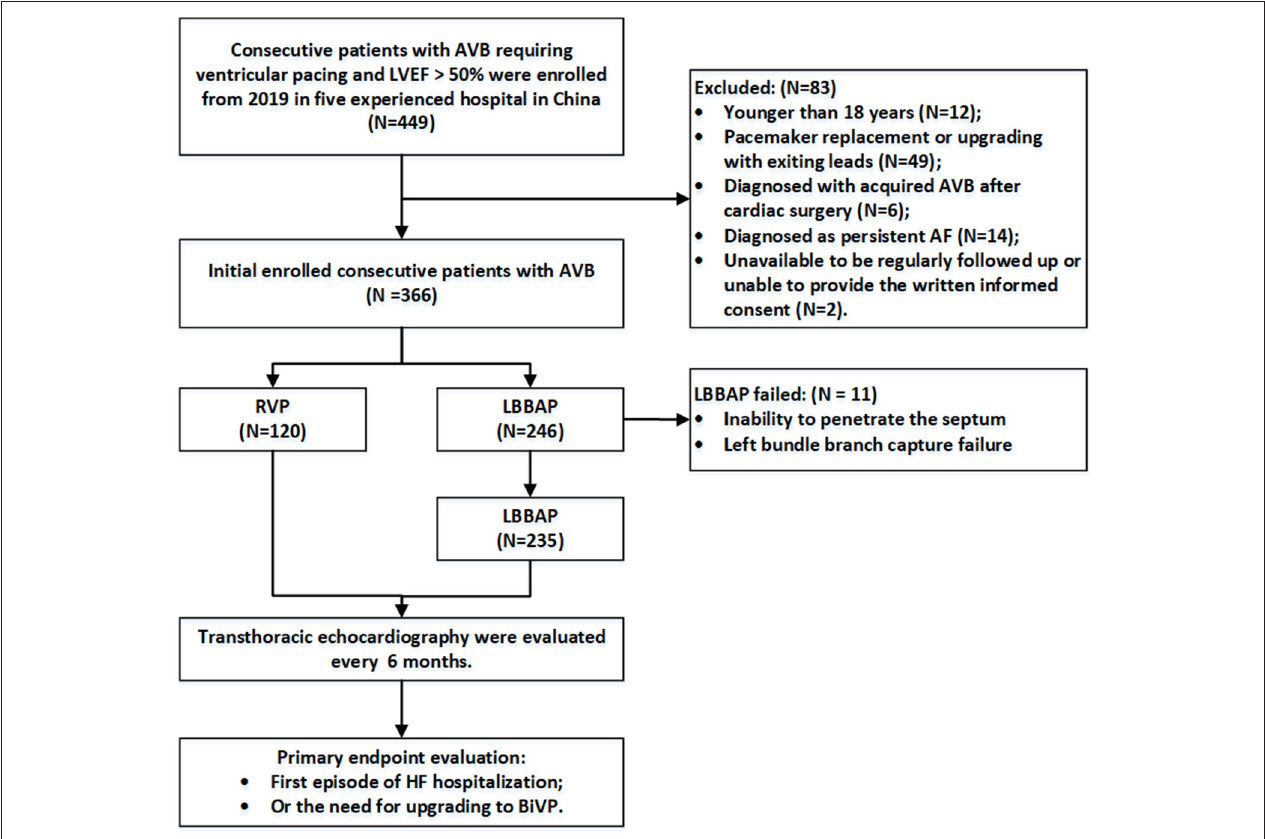
FIGURE 1 | Flowchart of the study population enrollment. AVB, atrioventricular block; RVP, right ventricular pacing; LBBAP, left bundle branch area pacing; AF, atrial fibrillation; HF, heart failure; BiVP, biventricular